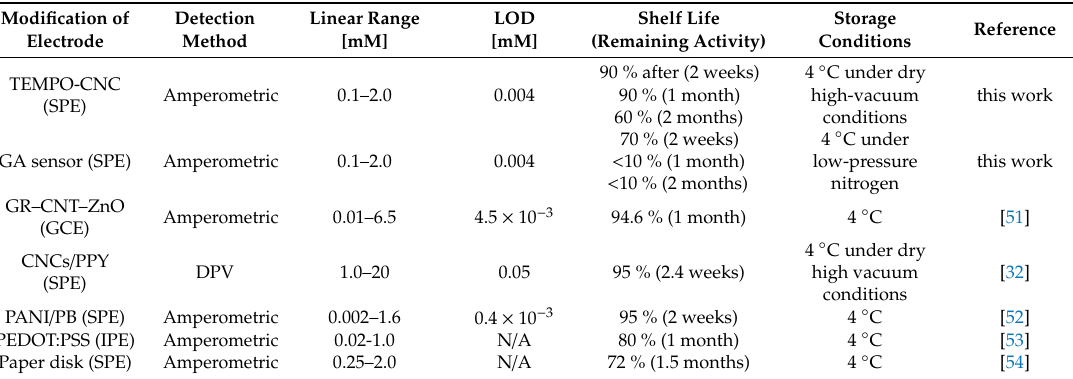
Table 1. Comparison of the TEMPO-CNC glucose sensor with previously reported enzymatic glucose biosensors. SPE: screen-printed electrode; DPV: differential pulse voltammetry; GCE: glassy carbon electrode; IPE: Injekt printing electrode; N/A: not available.